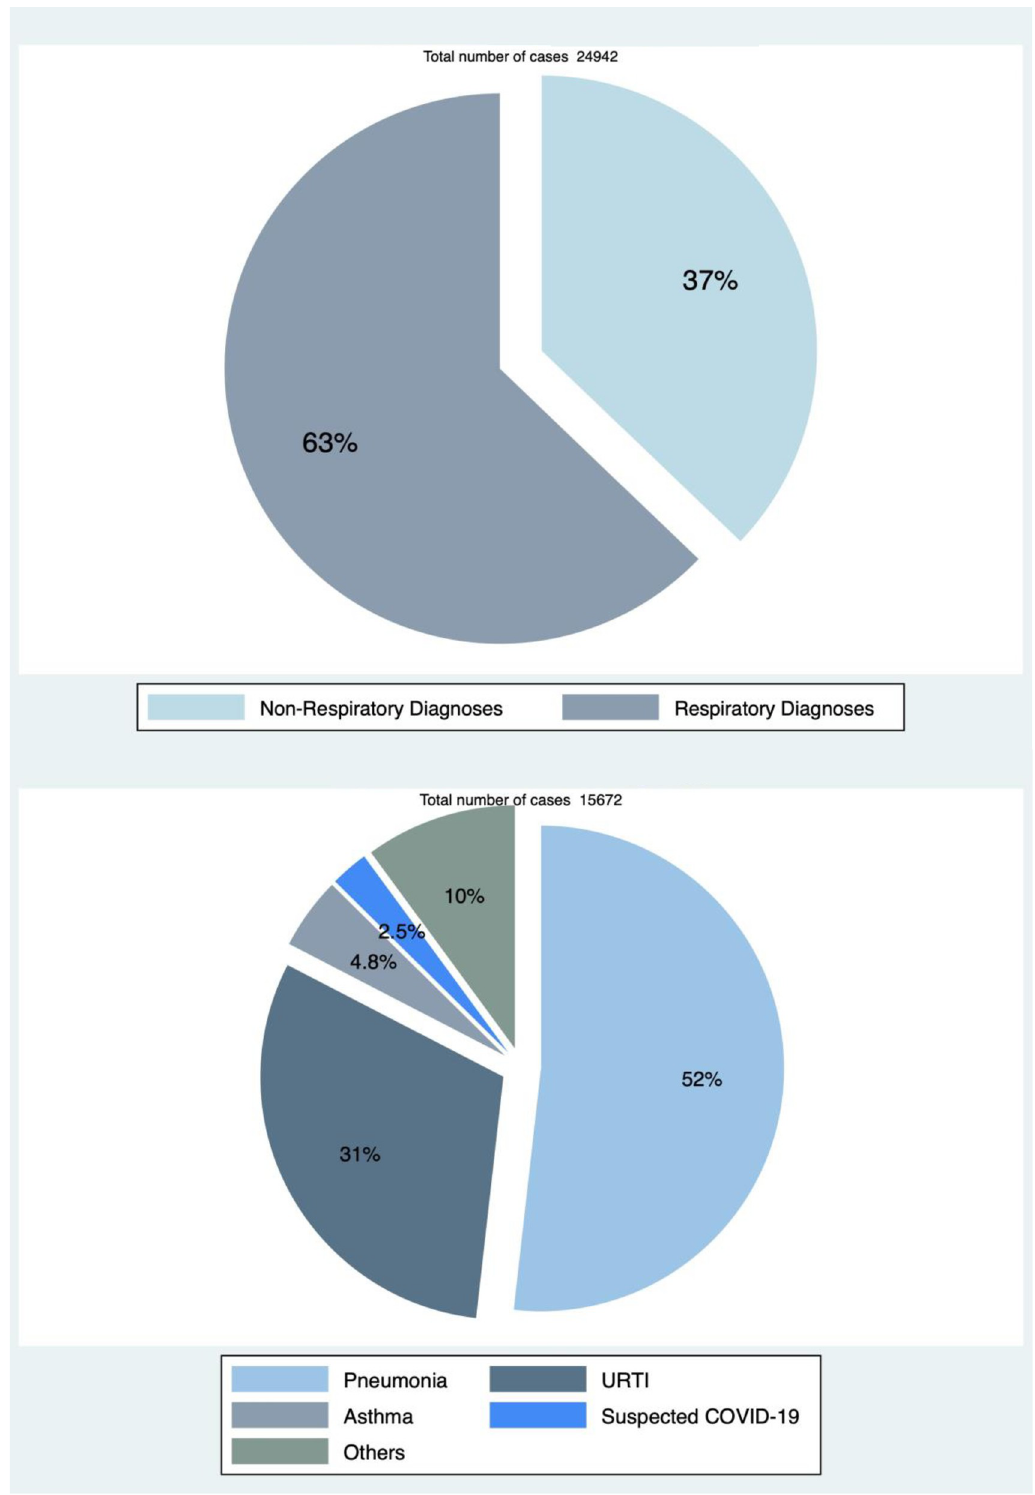
Fig 3. Diagnoses of patients with respiratory conditions presenting to Muhimbili National Hospital.